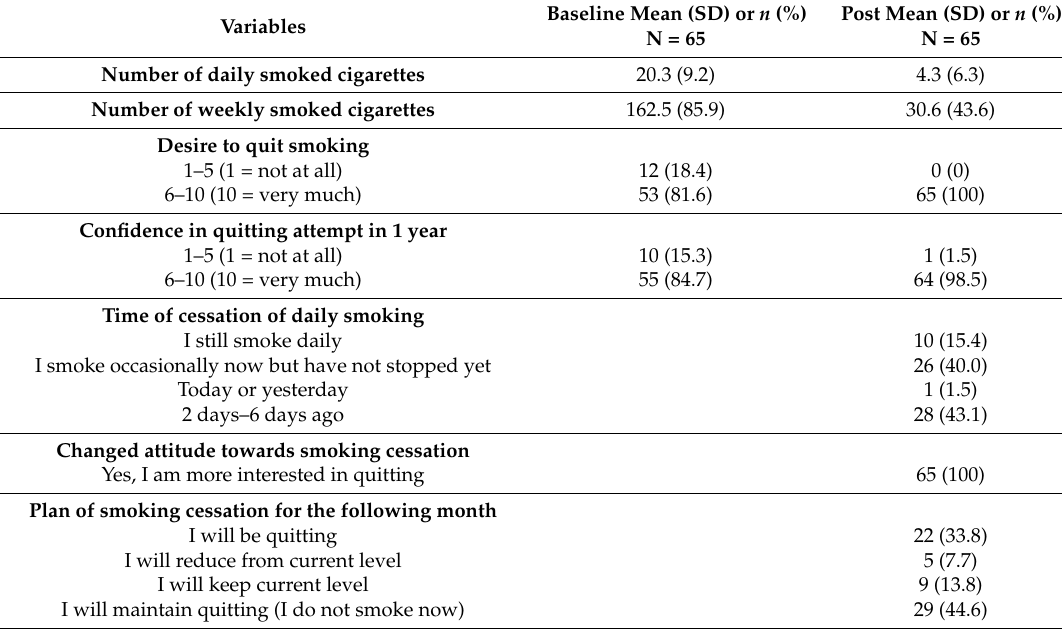
Table 5. Smoking status and cessation before and after the Sehatack program (N = 65).